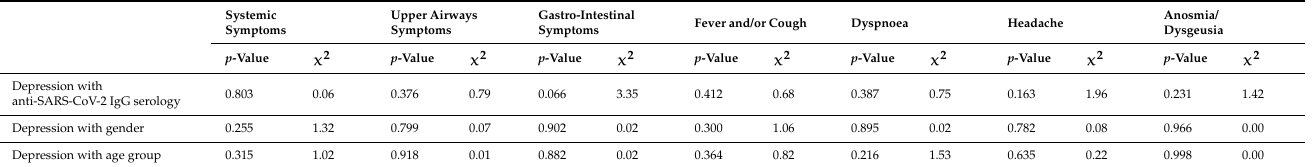
Table A6. Interaction effects between depression scores with serology status, gender and age group at baseline (April–June 2020), Geneva (N = 576).